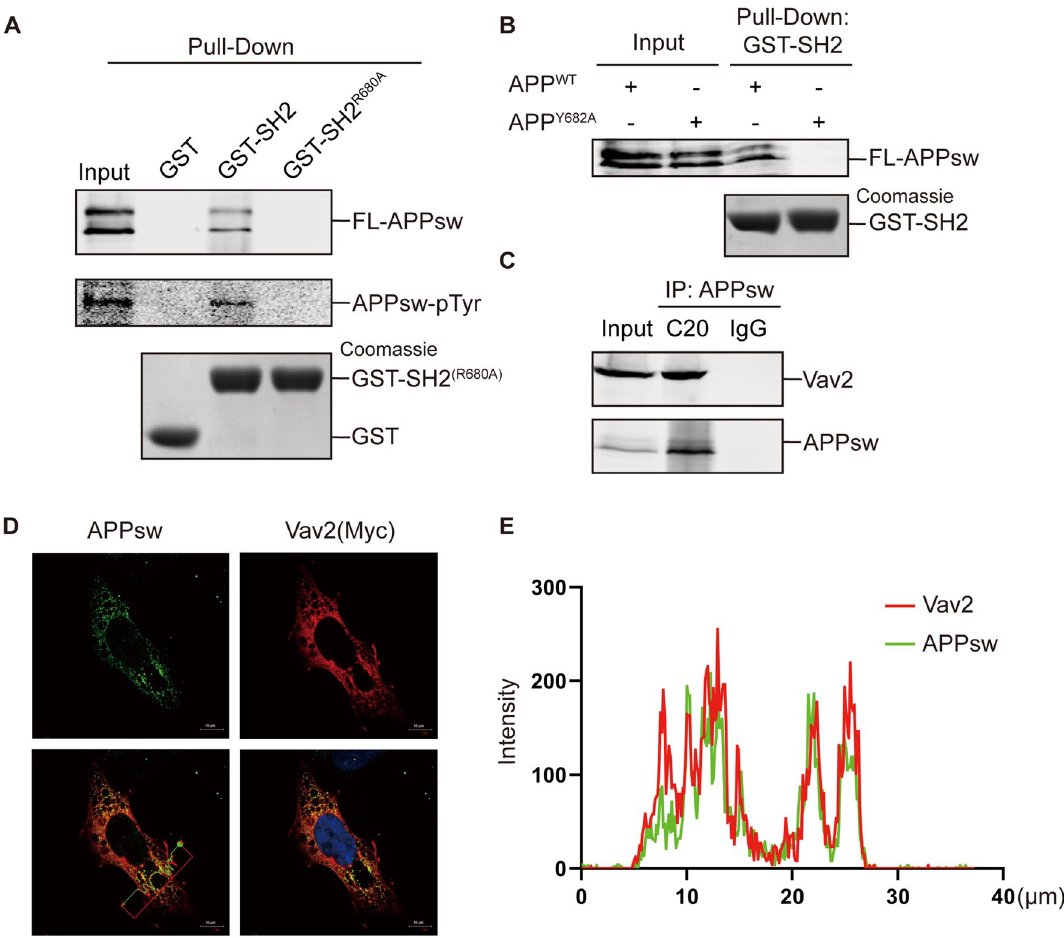
Figure 4. Interaction of Vav2 with full-length APP in cells. ( A ) GST pull-down assay of APP from lysate of cells stable expressing APP (20E2 cells) with the purified GST fusion proteins. GST fusion proteins were detected by Coomassie blue staining. FL-APPsw were detected by western blot using C20 antibody and the Tyr- phosphorylated APP were detected by western blot using anti-Phospho-Tyrosine antibody. Original blots and gels are presented in Supplementary Figures. ( B ) GST pull-down assay of the wild type and mutant of APP with purified GST-SH2 fusion proteins. Original blots and gels are presented in Supplementary Figures. ( C ) Co-IP was performed using HEK293 cells transfected with Vav2-Myc and pAPPsw. C20 was used as the pull-down antibody and anti-myc antibody was used as detection antibody. Original blots are presented in